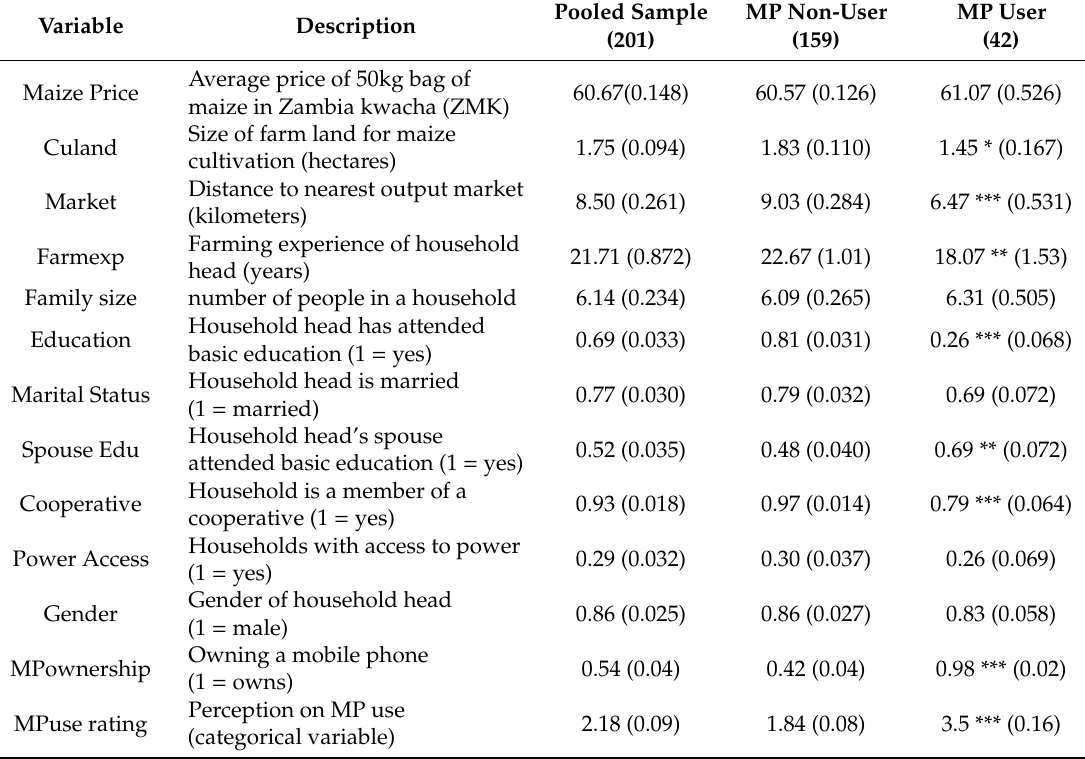
Table 1. Descriptive statistics of